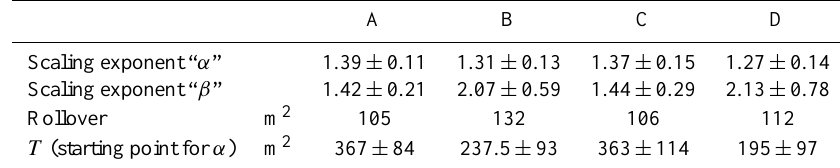
Table 2. Parameters for the “double Pareto” probability density function used to model the distribution of the landslide areas in the two inven- tories. (A) Photo-interpreted landslide inventory map, PI, (B) semi-automatic landslide inventory map, SA, (C) photo-interpreted landslide inventory map without soil slips, (D) semi-automatic landslide inventory map without soil slips.